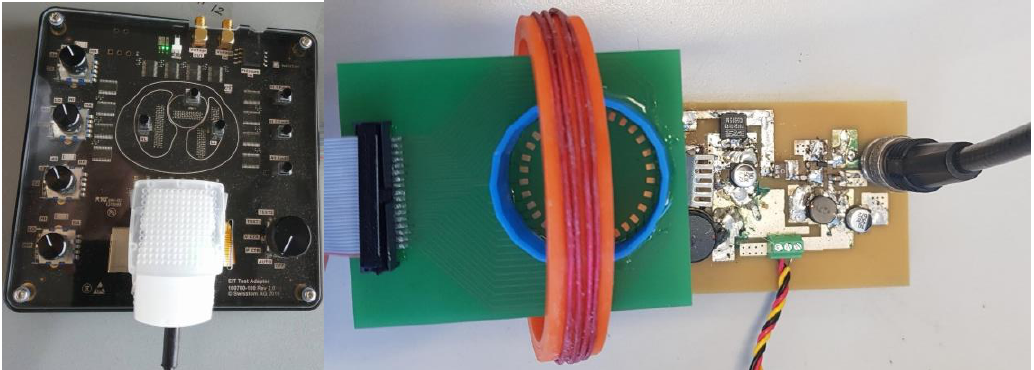
Figure 4. Experimental setup for imaging various AuNP solutions when activated with the designed PA operating at 13.56 MHz frequency.